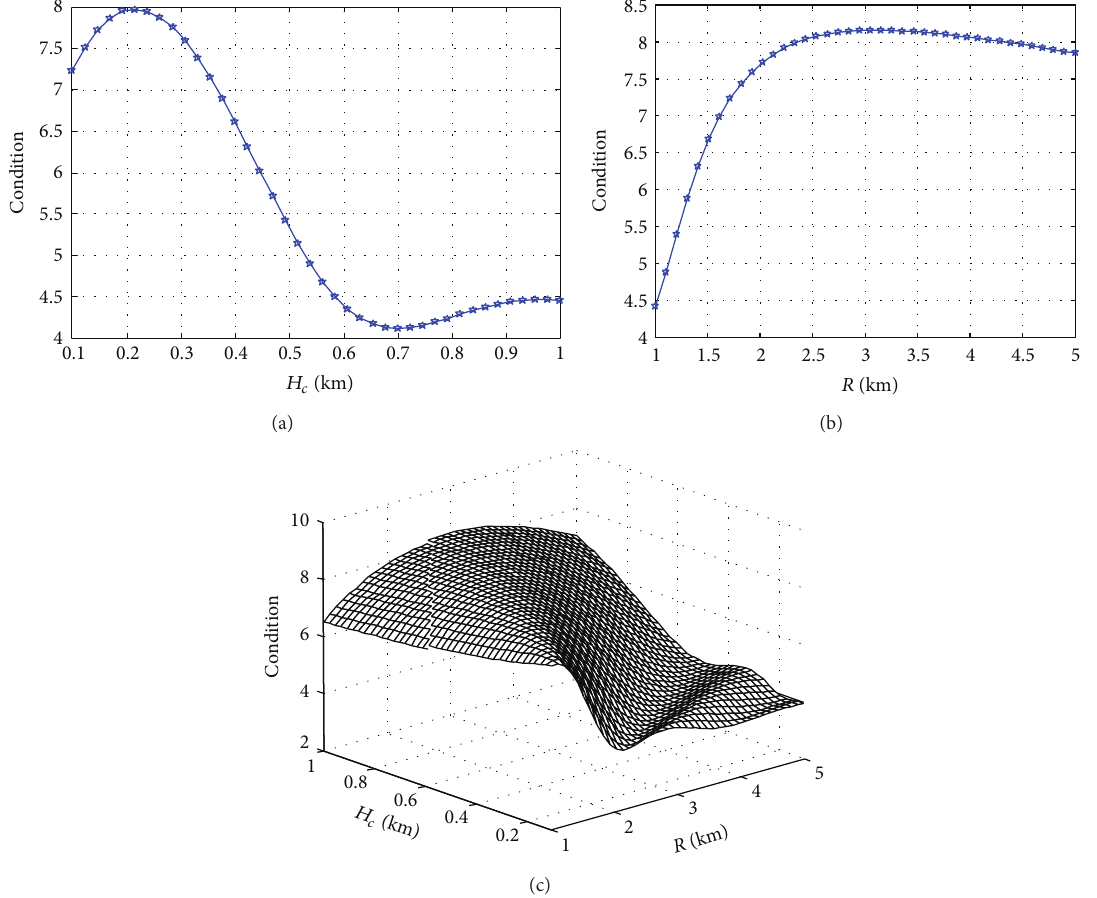
Figure 8: Influence of the diffuser parameters on the condition number of channel matrix. (a) Height of diffuser; (b) radius of diffuser; (c) three-dimensional